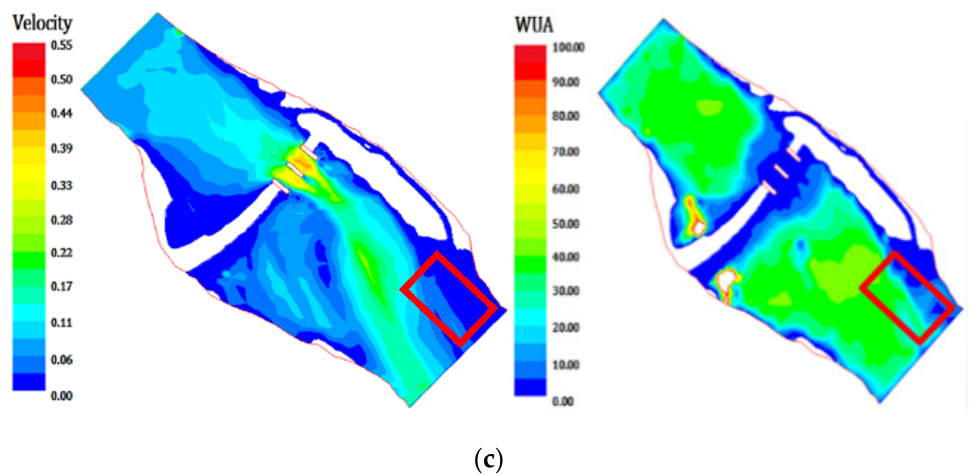
Figure 9. Presentation of the calculated values of velocities (m/s) and the weighted Usable Areas in the region of Gangjeong-Goryeong Weir in ( a ) April; ( b ) May; ( c ) June.